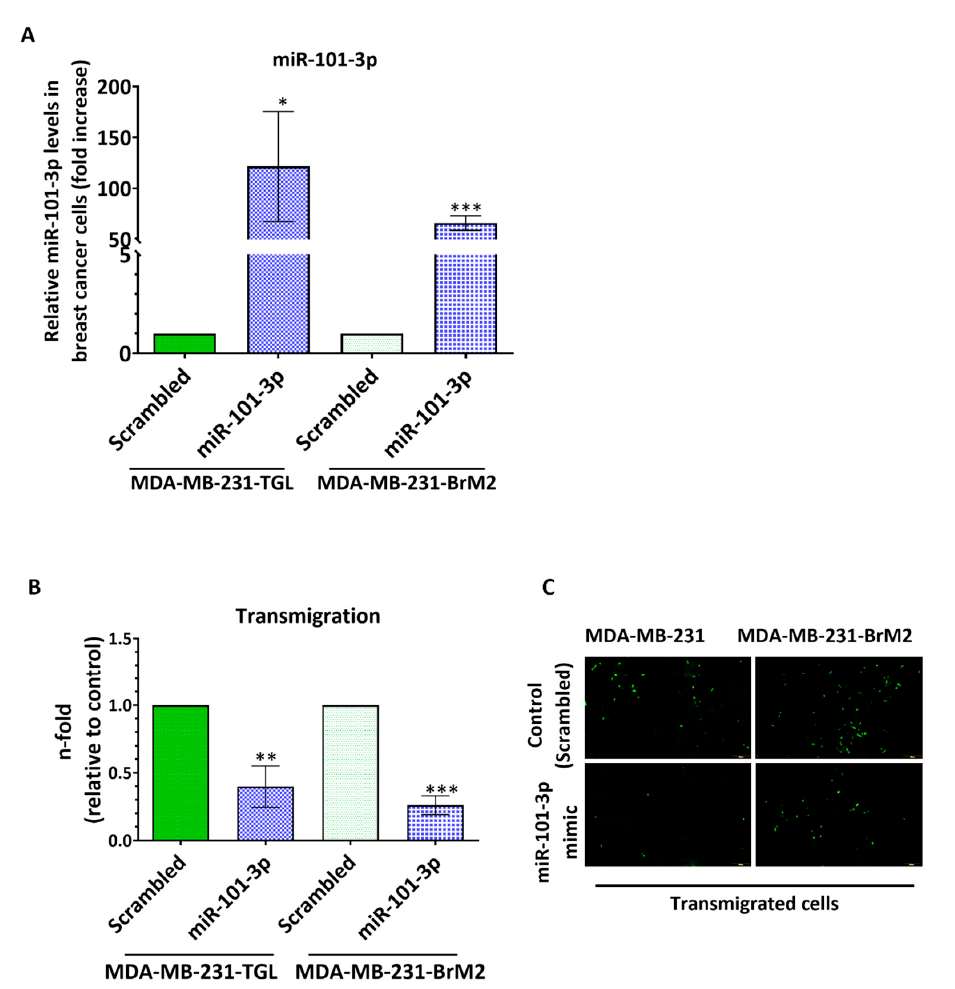
Figure 5. Ectopic upregulation of miR-101-3p in low expressing breast cancer cells reduces BC trans-endothelial migration.MDA-MB-231-TGL and MDA-MB-231-BrM2 cells were transfected with miR-101-3p mimic (5 nM final concentration) or with scrambled control. ( A ) Relative miR-101-3p level expression was measured by real time PCR from total RNA. The small nuclear RNA U6 was used as internal control. ( B ) The transmigration abilities of the di ff erent BC cells were examined by the trans-endothelial migration assay. ( C ) Representative images of transmigrated fluorescently labelled MDA-MB-231-TGL and MDA-MB-231-BrM2 (small green cells) in control and miR-101-3p mimic transfected cells. * p < 0.05, ** p < 0.01, *** p < 0.001.